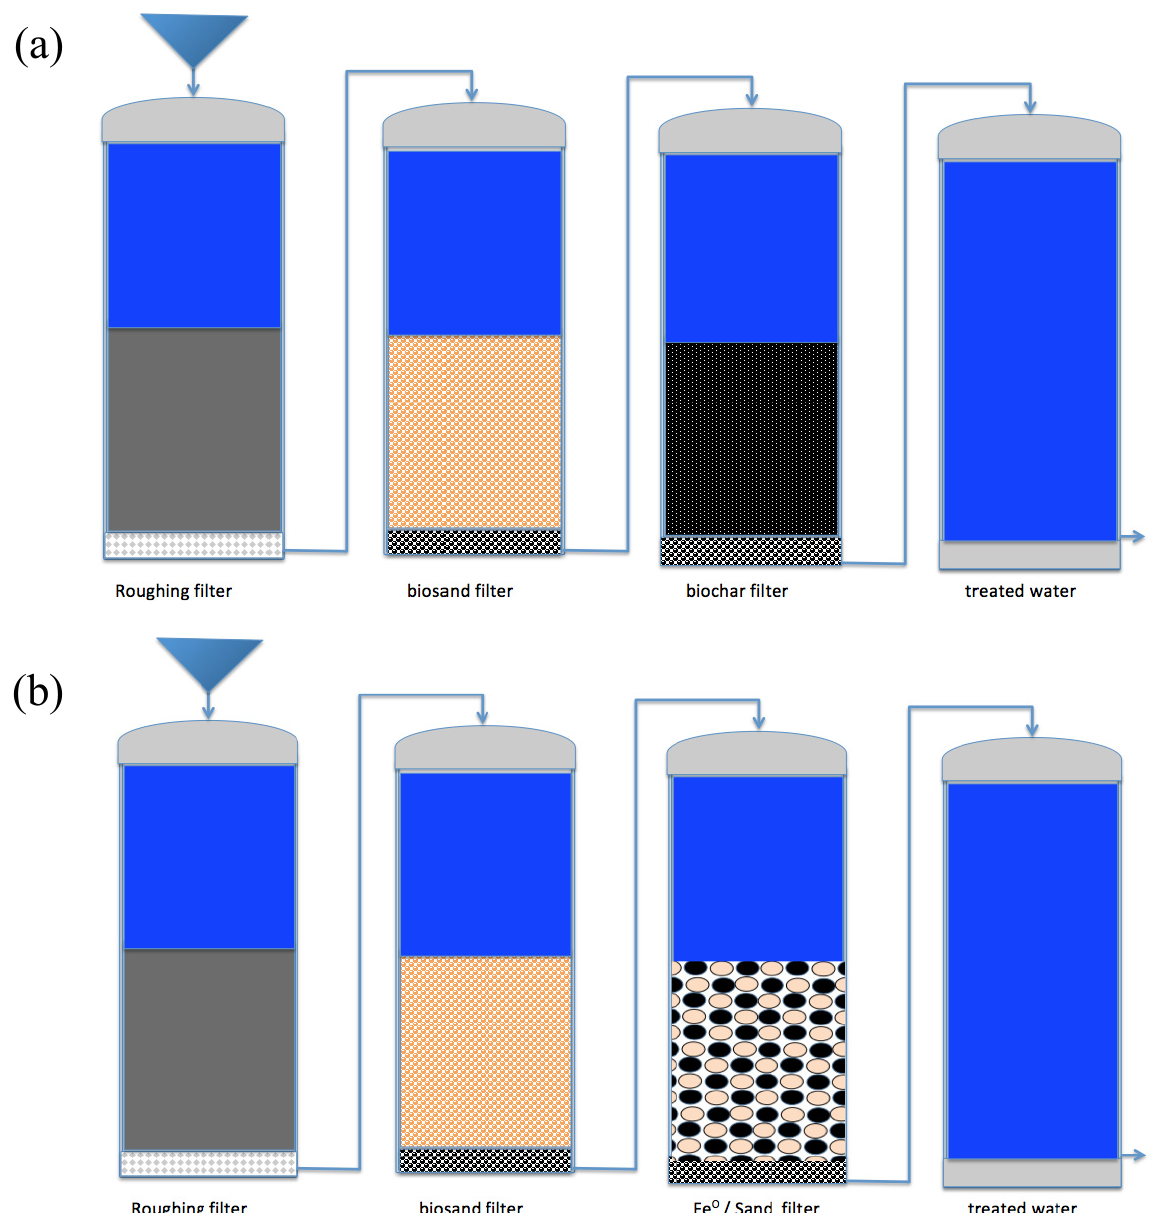
Figure 4. Concept for the configuration of multi-barrier water treatment systems: ( a ) the sustainable biochar-based system; and ( b ) a comparable Fe 0 -based system. Adapted